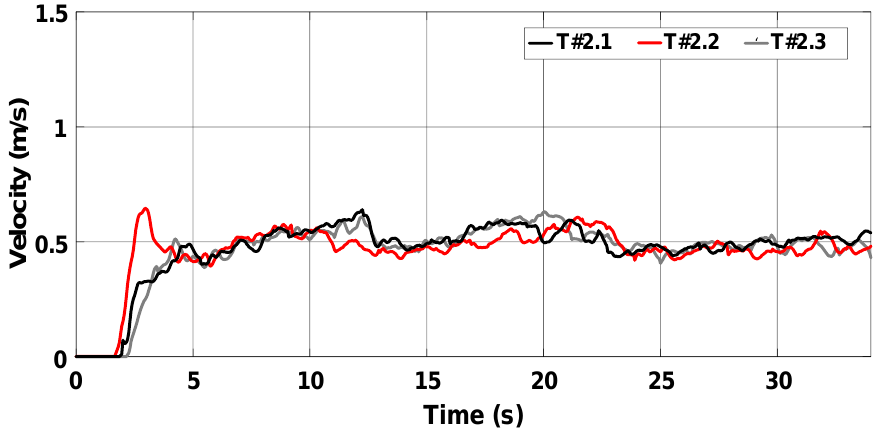
Figure 21. Basic descriptive statistics applied to data obtained during the trial sessions carried out on firm soil with the slip manually controlled by the operator. The average velocity of the electric tractor during tests T#2.1, T#2.2, and T#2.3 varied between 0.49 m/s and 0.52 m/s, as shown in Figure 22. The current drawn from the battery ranges between 57.05 A and 59.54 A in Figure 23, resulting in an average power varying between 2742.94 W and 2854.64 W. The resulting energy consumption in Figure 24 varies between 21.94 Wh and 24.51 Wh. Table 2 summarizes the main parameters associated with the data recorded during the tests.